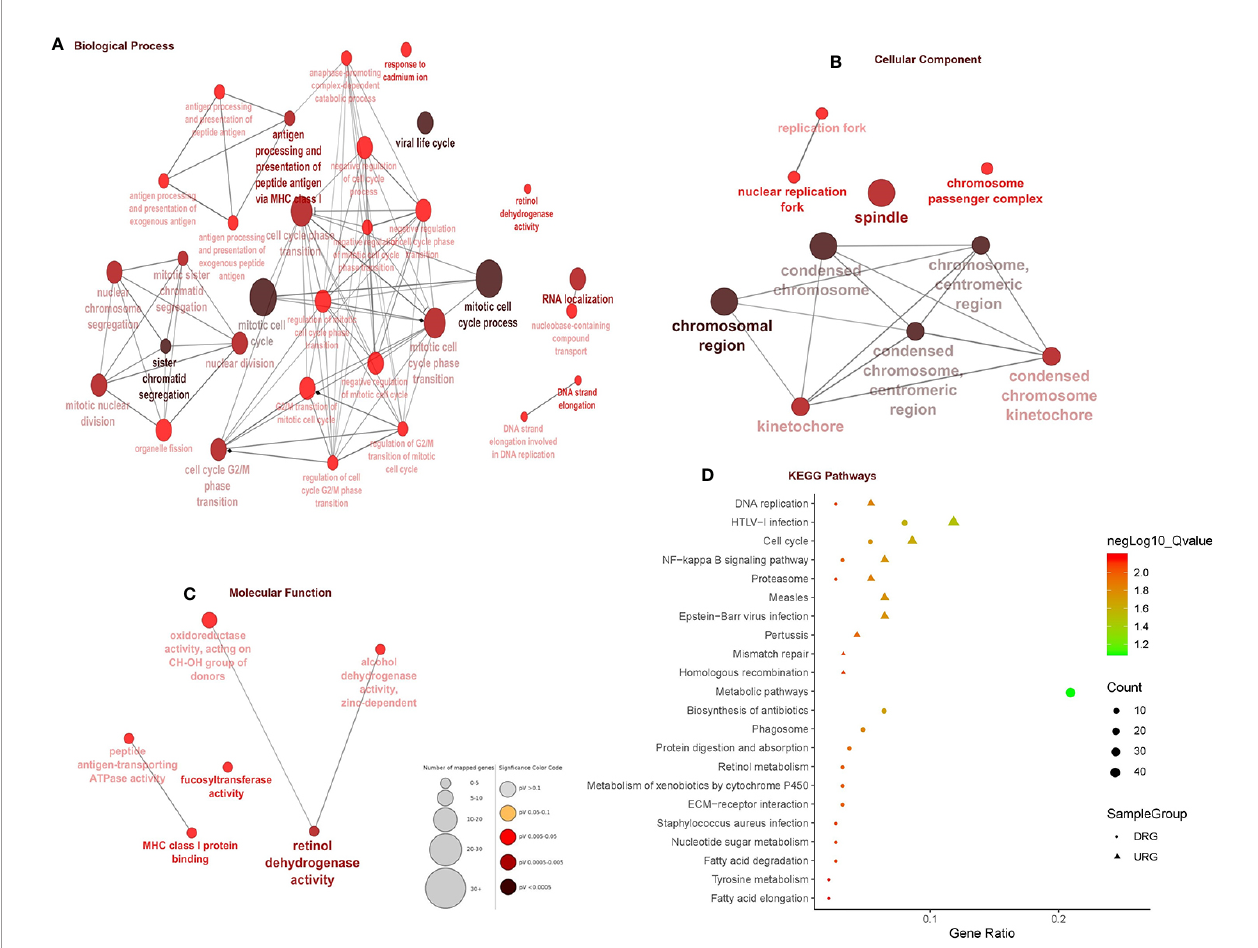
FIGURE 2 | Gene ontology and pathway enrichment analysis. (A) Biological process analysis. (B) Cellular component analysis. (C) Molecular function analysis. (D) KEGG pathway